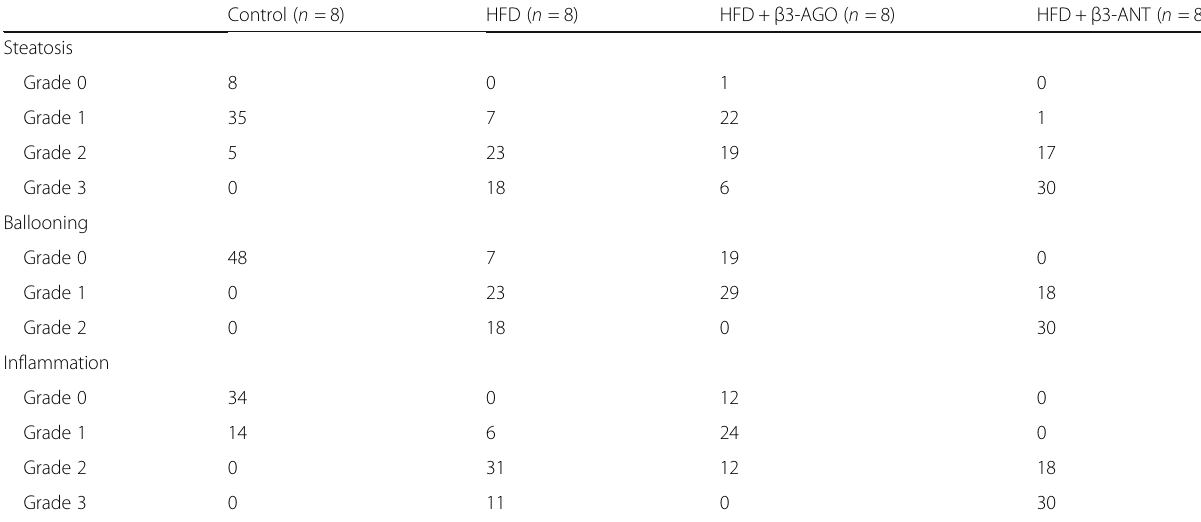
Table 3 Histopathological findings in liver